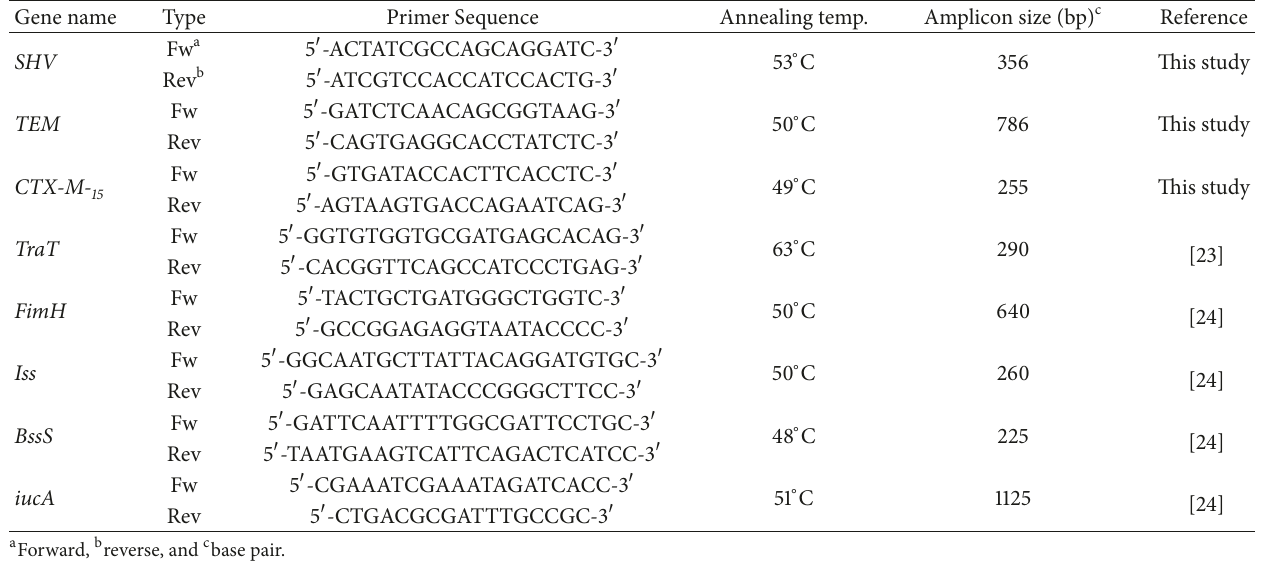
Table 1: Oligonucleotide primers used for extended spectrum 𝛽 -lactamase and virulence gene detection.